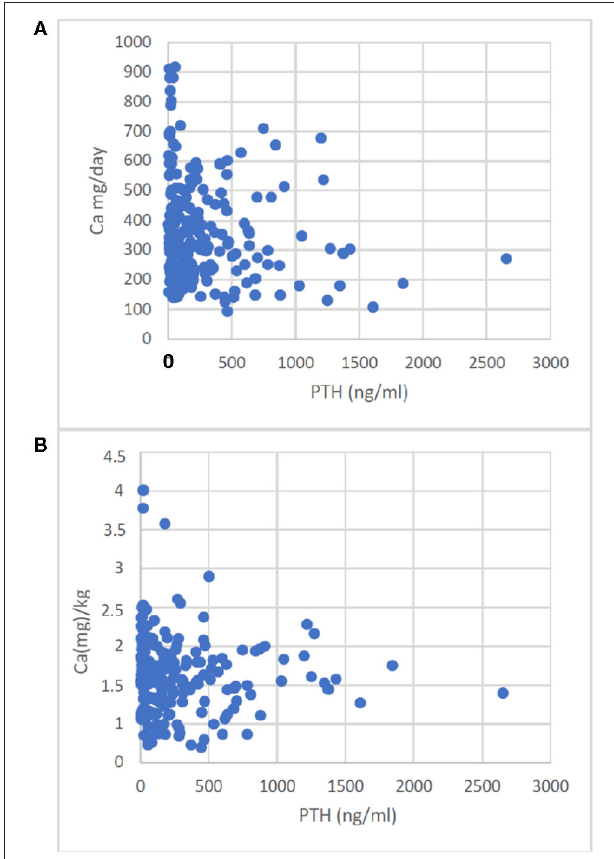
FIGURE 1 | Correlation of Ca-Intake with PTH. Enteral Ca-Intake given as absolute intake (A) or given as Ca(mg)/kg body weight (B) correlated with PTH. The correlations were A: r = –0.196, p < 0.0033; B: r = –0.136, p <